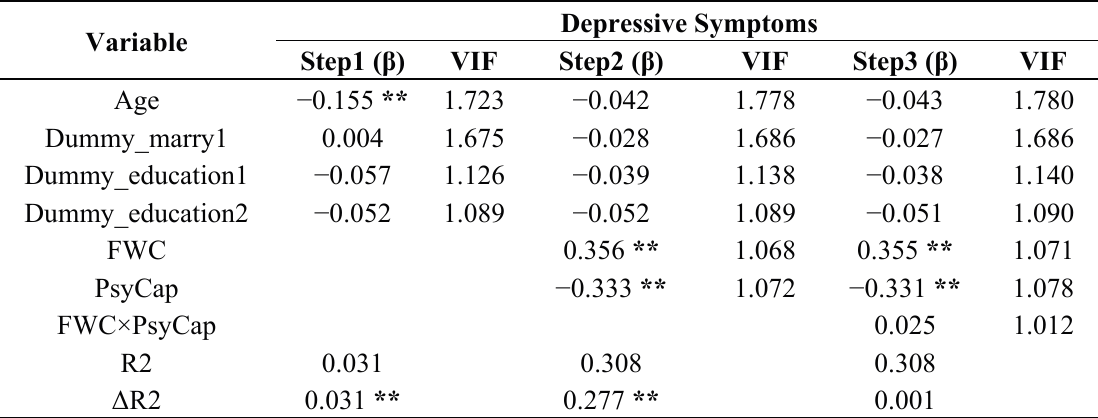
Table 9. FWC as the independent variable and PsyCap as the moderator in the regression